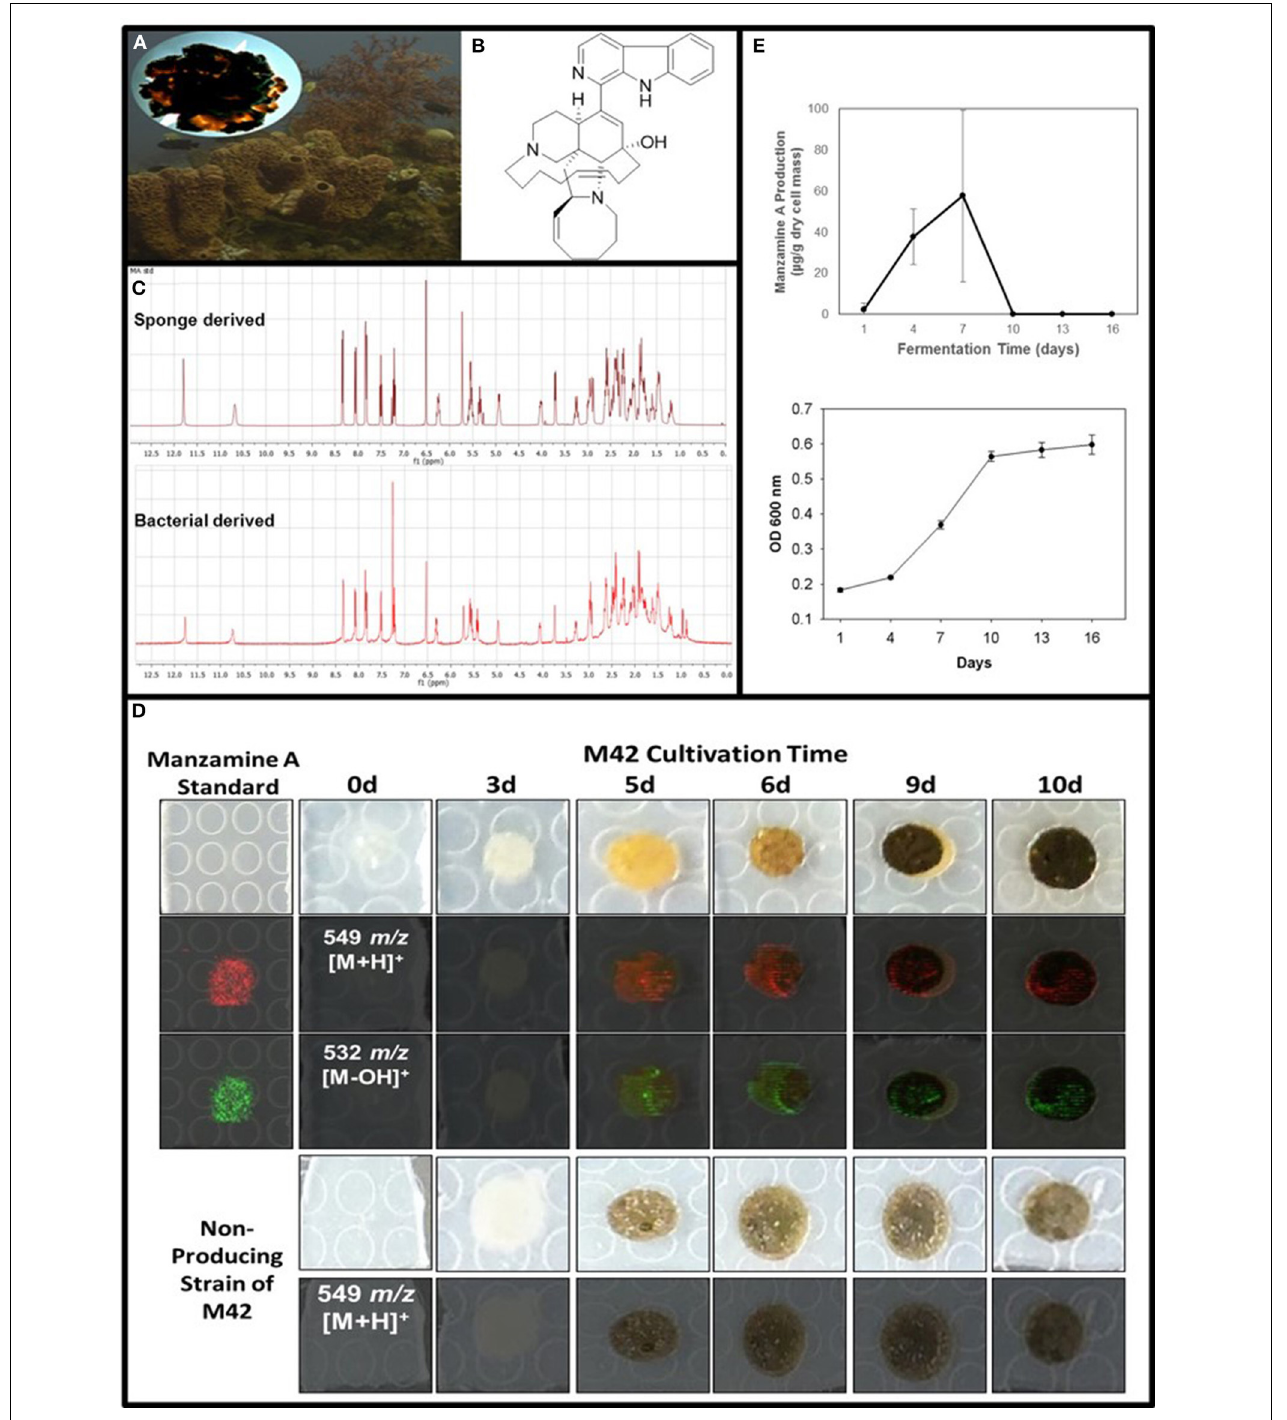
FIGURE 1 | Confirmation of manzamine A production by Micromonospora sp. M42. (A) Acanthostrongylophora ingens , a common Indo-Pacific manzamine producing sponge with the image of a colony of Micromonospora sp. strain M42 with orange mycelial growth and black spores. (B) Structure of manzamine A. (C) 1 H NMR analysis comparison of sponge derived and bacterial derived manzamine A. (D) MALDI-MS imaging of manzamine A production on ISP2 over 10 days. 1 st column: manzamine A standard control (10 μ g on ISP2 agar); 1st row: Producing M42 colonies; 2nd